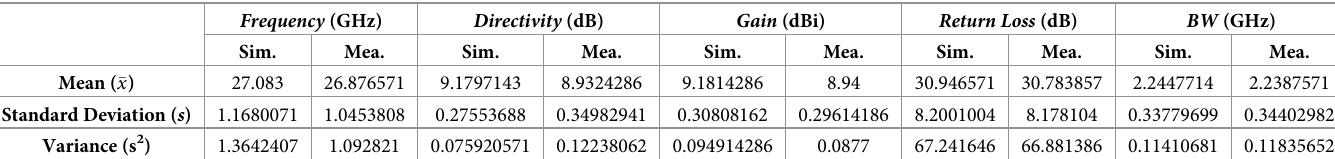
Table 4. Mean, variance and standard deviation simulated and measured variation of antenna design parameters with substrate thickness at 28GHz.